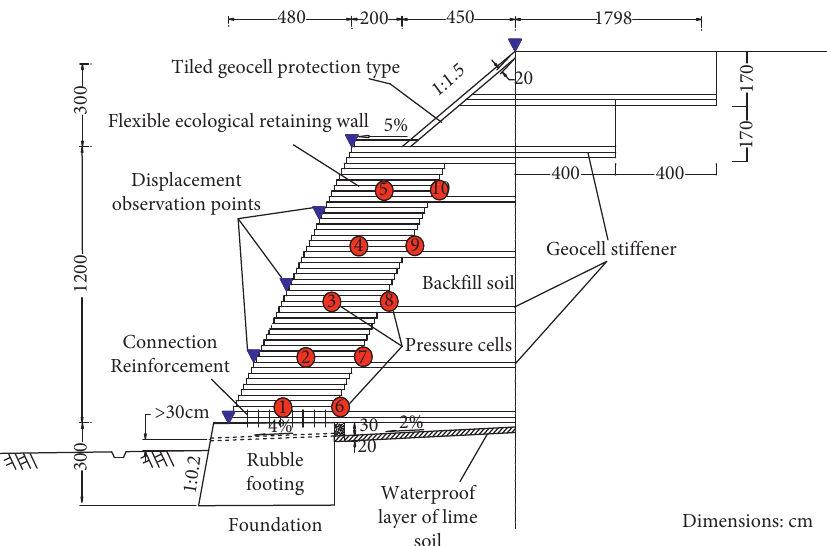
Figure 2: Design of a slope protection scheme and layout of test elements.